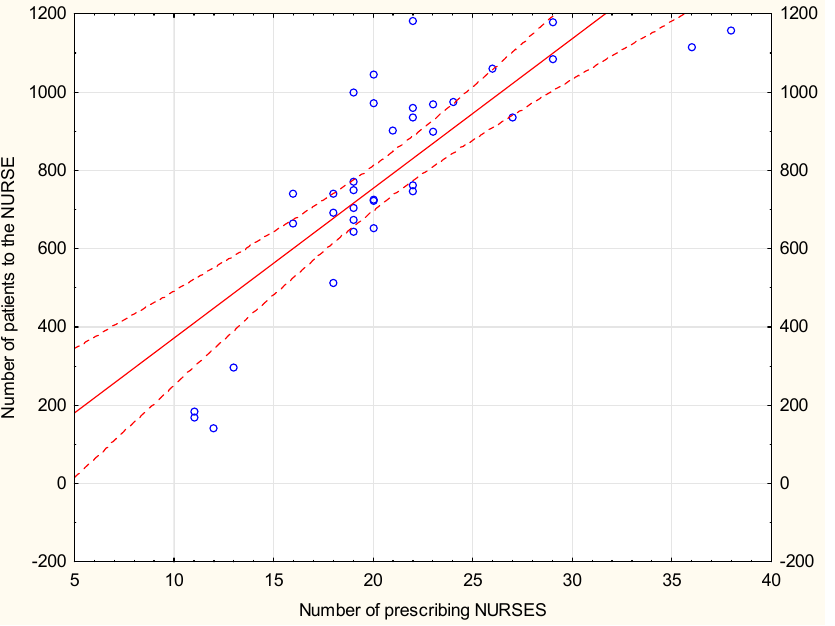
Figure 10. The correlation between the number of patients visiting the nurse and the number of nurses with the license to prescribe